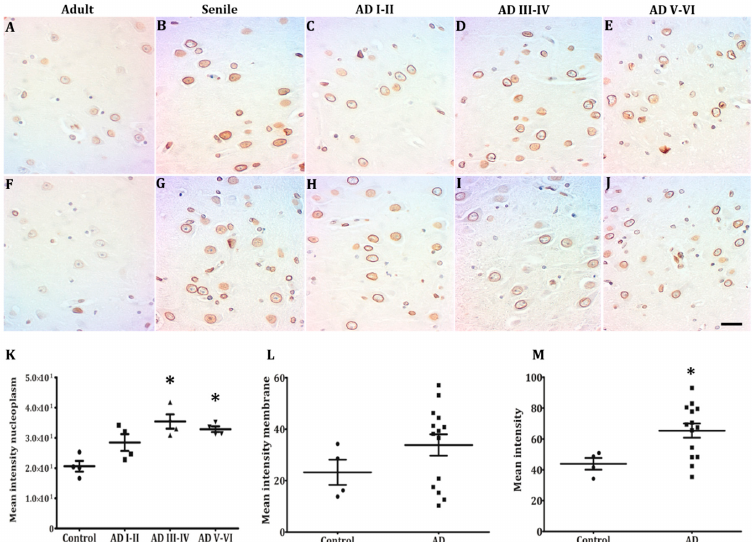
Figure 4. Lamin B2 in pyramidal hippocampal neurons. Lamin B2 immunopositivity in adults is mostly perinuclear ( A , F ) and starts appearing in the nucleoplasm in senile subjects ( B , G ). Pyramidal neurons in both CA1 and CA3 present either intense perinuclear immunopositivity or homogeneous staining over the nucleoplasm ( C – E , H – J ), 40× microphotographs, scale bar—10 µm. Quantification of immunopositivity. Lamin B2 immunostaining in nucleoplasm increased significantly in the middle and late AD stages ( K , M ). The intensity of the membranes clearly reveals two populations of neurons (H, high and low intensity), and Lamin B2 mean intensity increased significantly in AD ( L ). Each point represents the image analysis of 50 cells per subject in CA1 and CA3 regions. Graphs express mean ± SD, * p < 0.05. See the text for further details of image analysis and statistics. Int. J. Mol. Sci. 2019 , 20 , x FOR PEER REVIEW